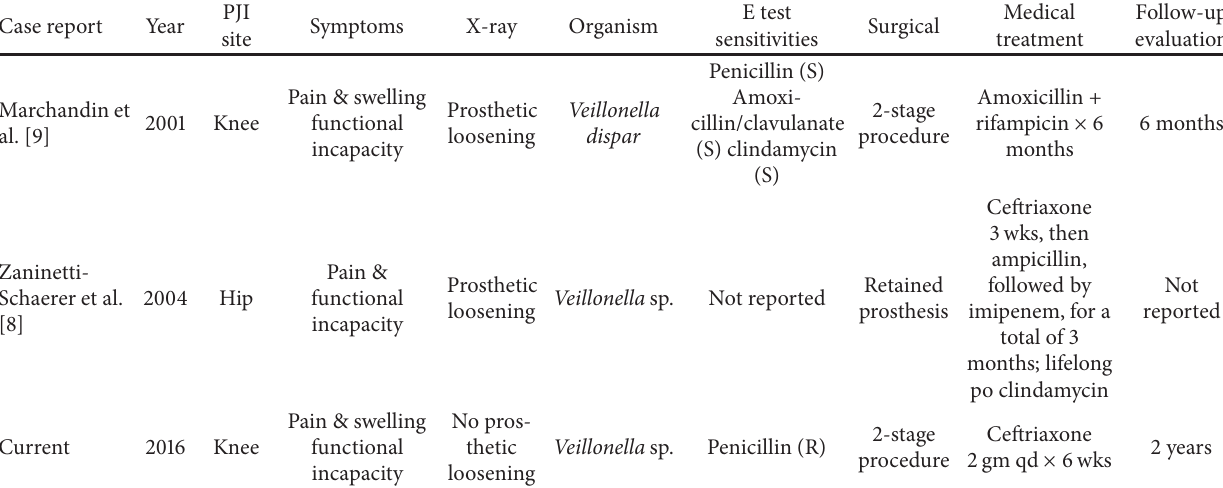
Table 3: Monomicrobial Veillonella prosthetic joint